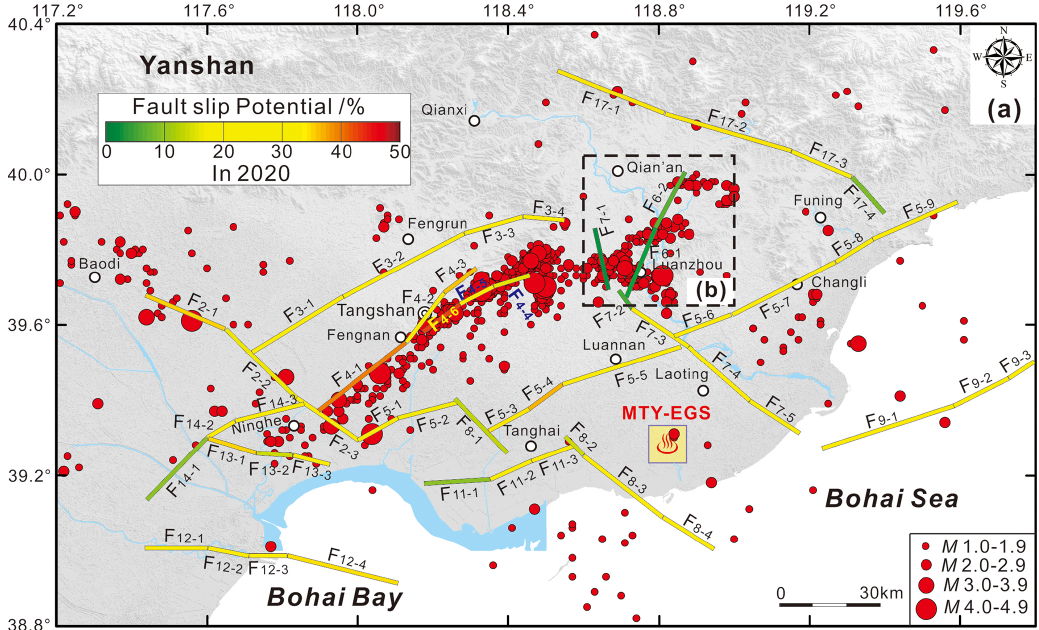
Figure 8. The probabilistic fault slip potential on the mapped faults without any fluid pressure perturbation in 2020 and the recent earthquakes (2009–2019) with a magnitude of M 1.0-4.9 in the Tangshan seismic region (National Earthquake Data Center, China).